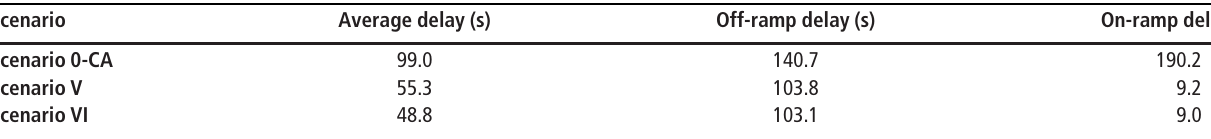
Table 4 Delay output comparison results after setting the con fl ict avoidance area